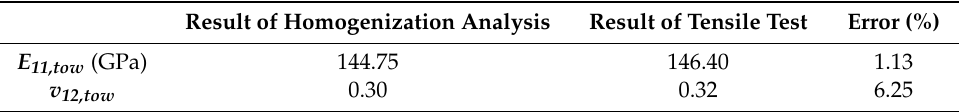
Table 4. Comparison of the homogenization analysis and tensile test results for unidirectional